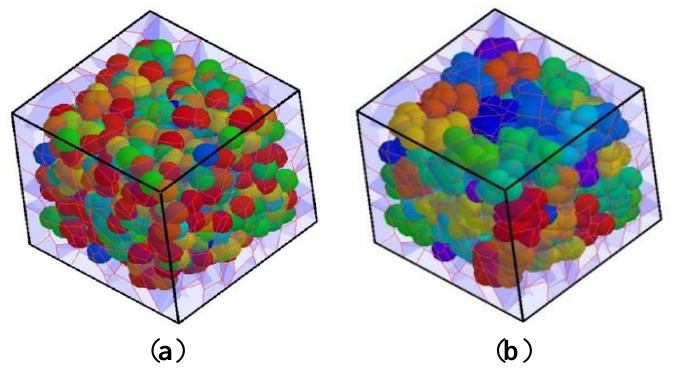
Figure 4. Different clusters and their distributions of particles for the same cluster number: ( a ) scattering without neighbor relationships; ( b ) clustering with neighbor relationships.